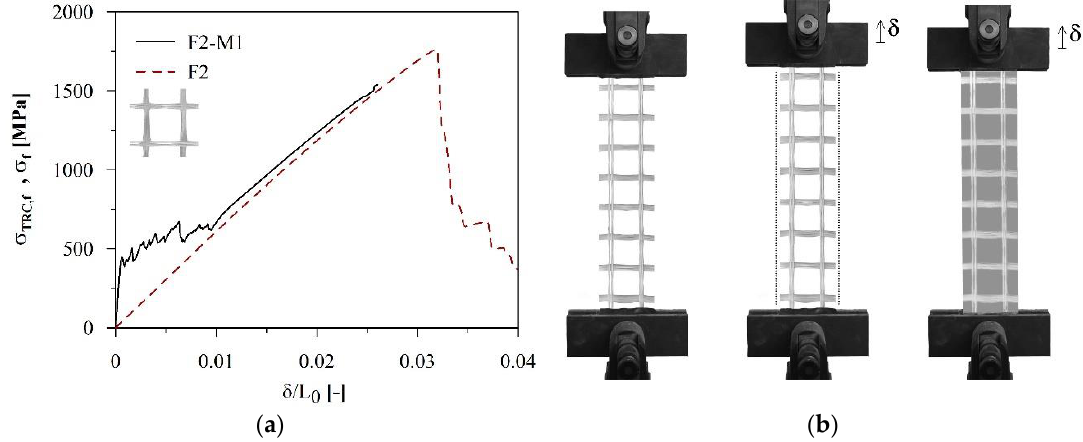
Figure 22. Comparison between F2-M1 composite and F2 fabric tensile responses ( a ); and negligible transverse contraction of Fabric F2 ( b ).